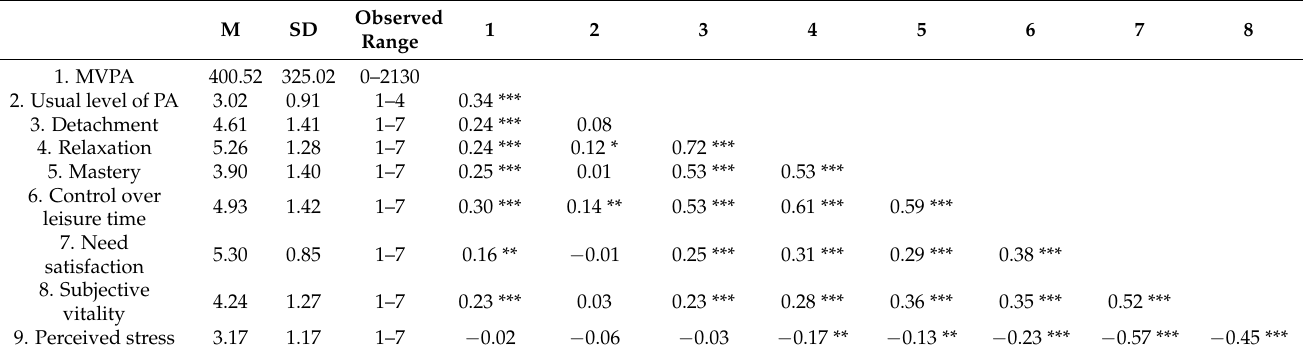
a latent variable representing well-being. Table 1. Correlation matrix for main variables included in the